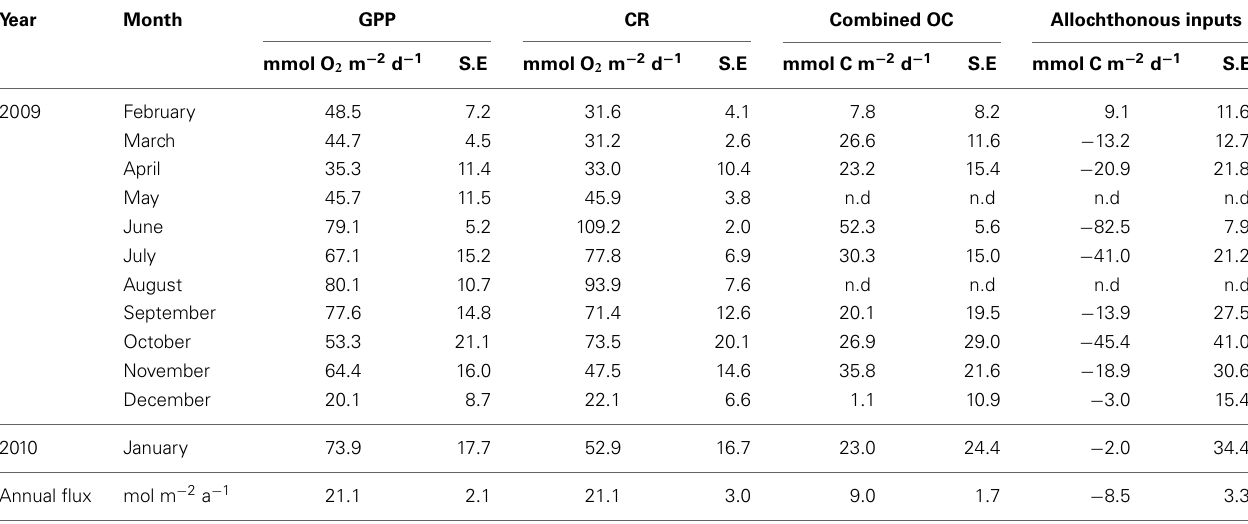
Table 4 | Mass balance to calculate the monthly inputs of allochthonous OC necessary to preserve the mass balance.